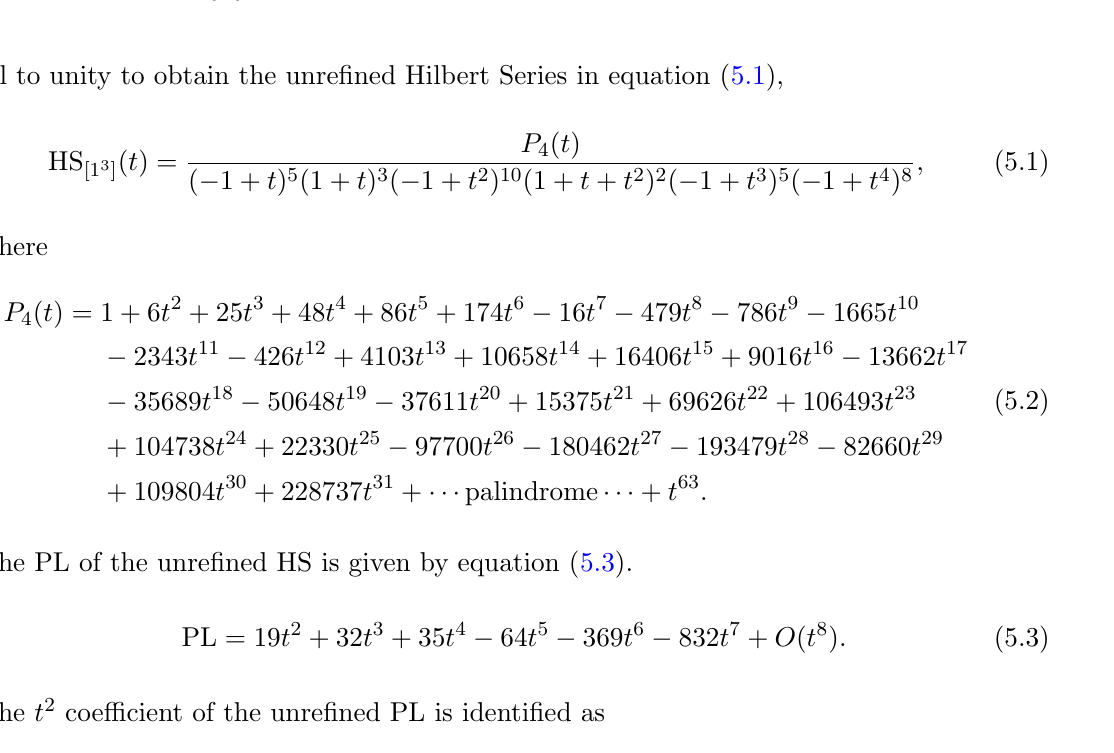
Figure 33 . P (3) quiver with SU(2) 3 (cid:2) C 2 global symmetry, b = 1, dim M H [1 3 ]